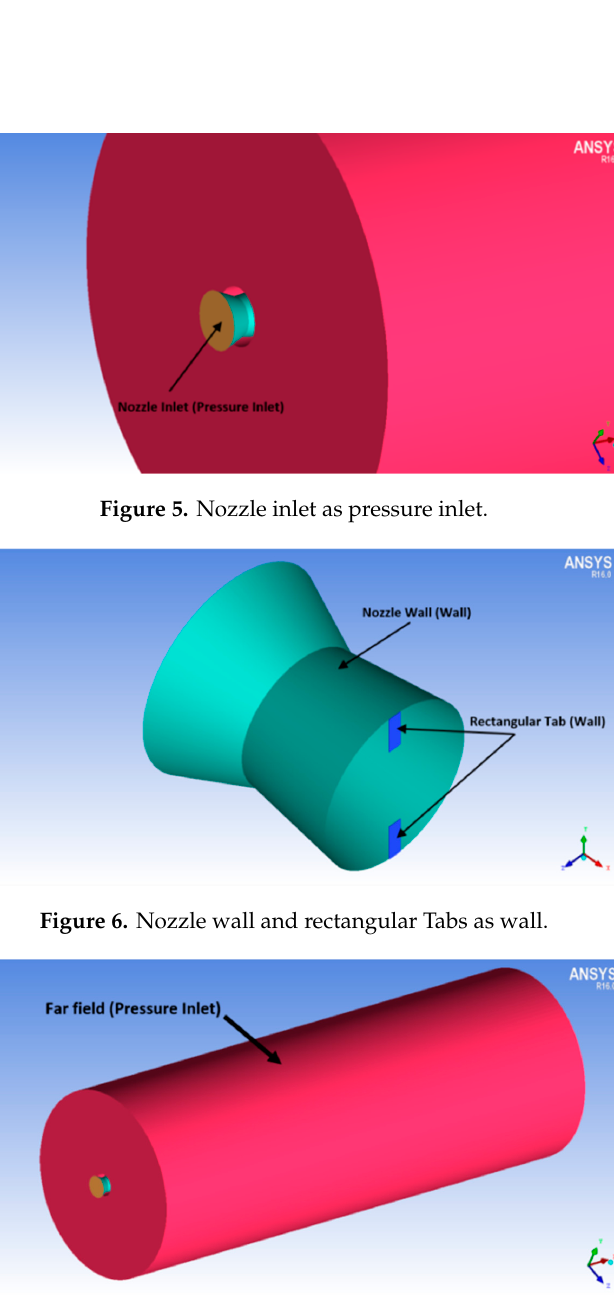
Figure 7. Far-field as pressure inlet.